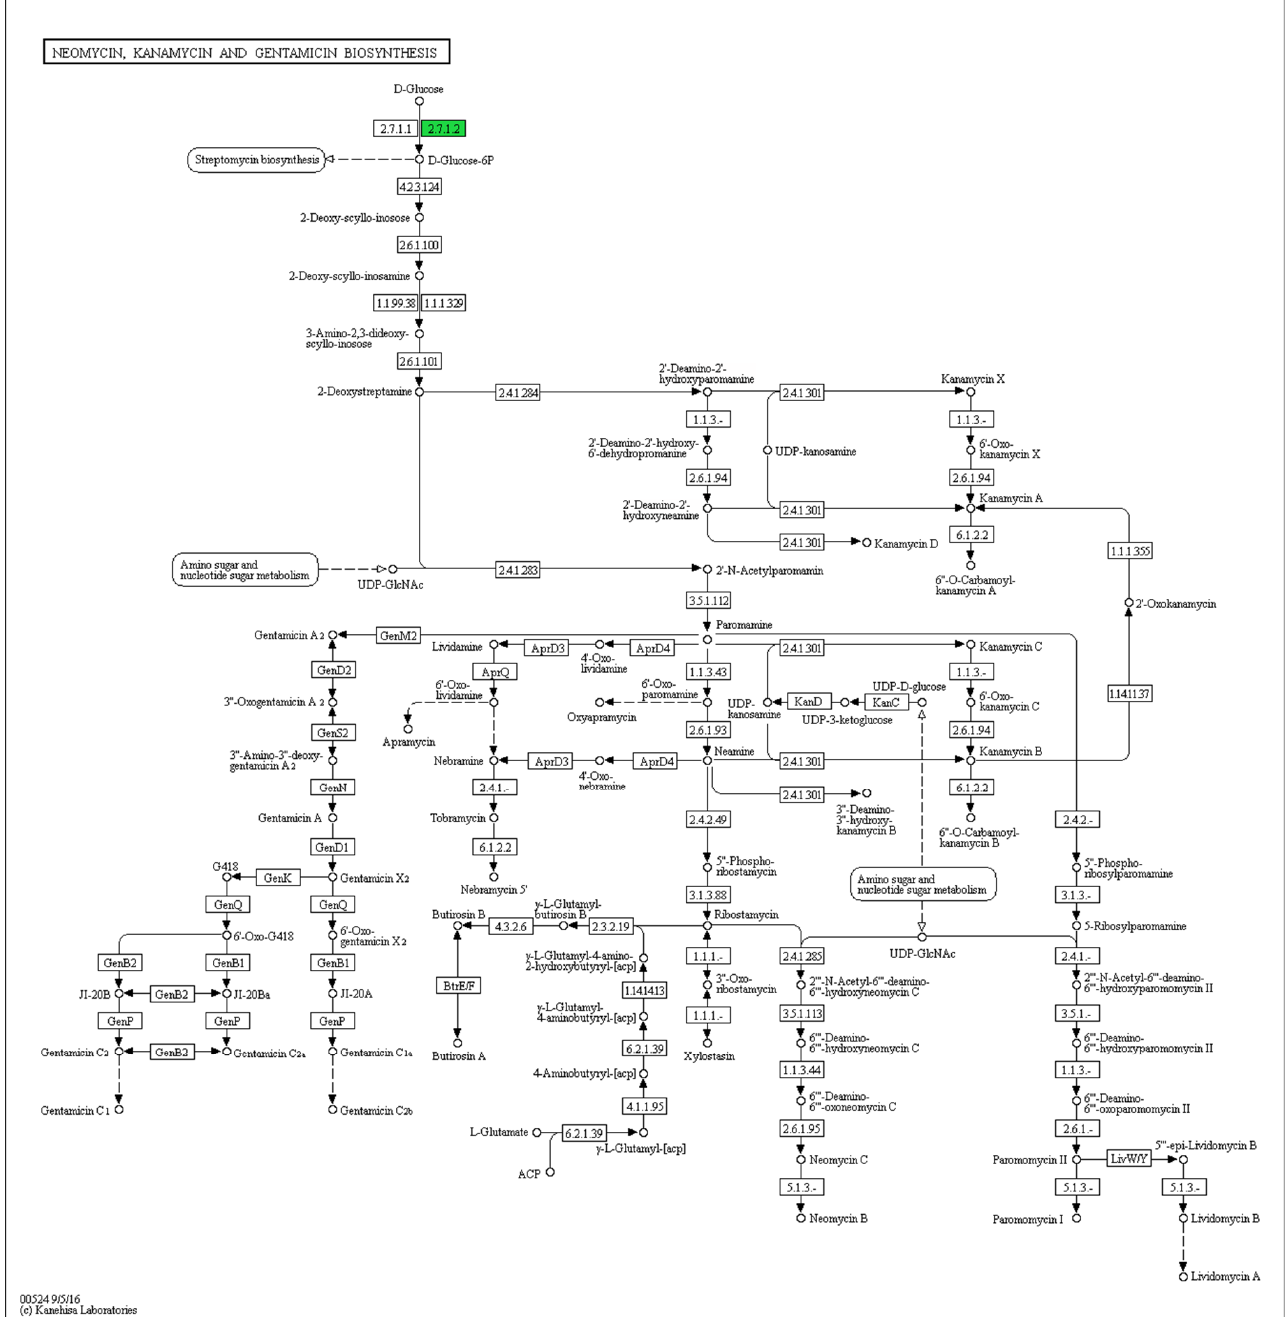
Figure 1. Antibiotic synthesis of neomycin, kanamycin and gentamicin. Source: KEGG database ( Kyoto Encylopedia Genes and Genomes ).